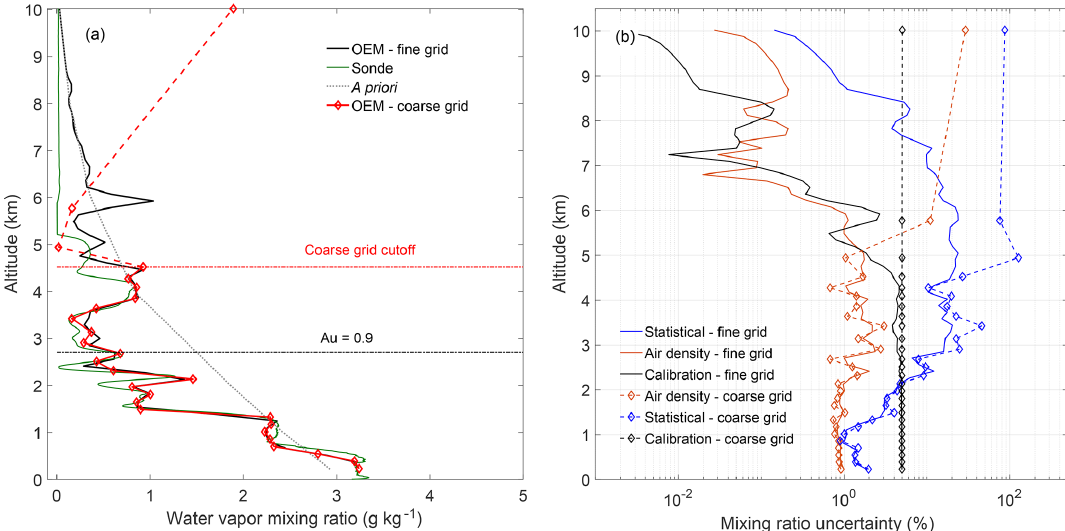
Figure 5. (a) The retrieved daytime water vapor profile for 22 January 2013 12:00UT. The fine-grid retrieval is in black and includes the a priori information. The coarse-grid retrieval is in red and the a priori (grey) has been removed. The radiosonde is shown in green. The points which we do not consider meaningful because their uncertainties are larger than 80% in the retrieval are shown in dashed red lines. The coarse-grid retrieval increases the last valid point by 2km (red dashed line) and now more closely resembles the radiosonde above the original cutoff altitude of 2.7km (black dashed line). (b) The three primary contributors to the uncertainty budget on 22 January 2013 12:00UT are shown for comparison: the statistical uncertainty, the uncertainty due to the calibration constant, and the uncertainty due to air density. The solid lines are the relative uncertainties from the fine-grid retrieval, and the dashed lines are from the coarse-grid retrieval. The a priori begins influencing the profile above 2km where the uncertainty